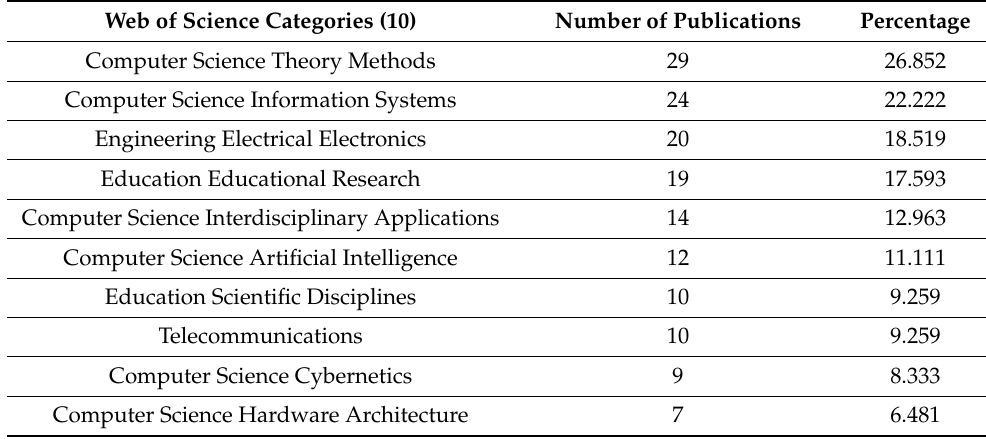
Table 3. Number of publications and categories from the WoS database.